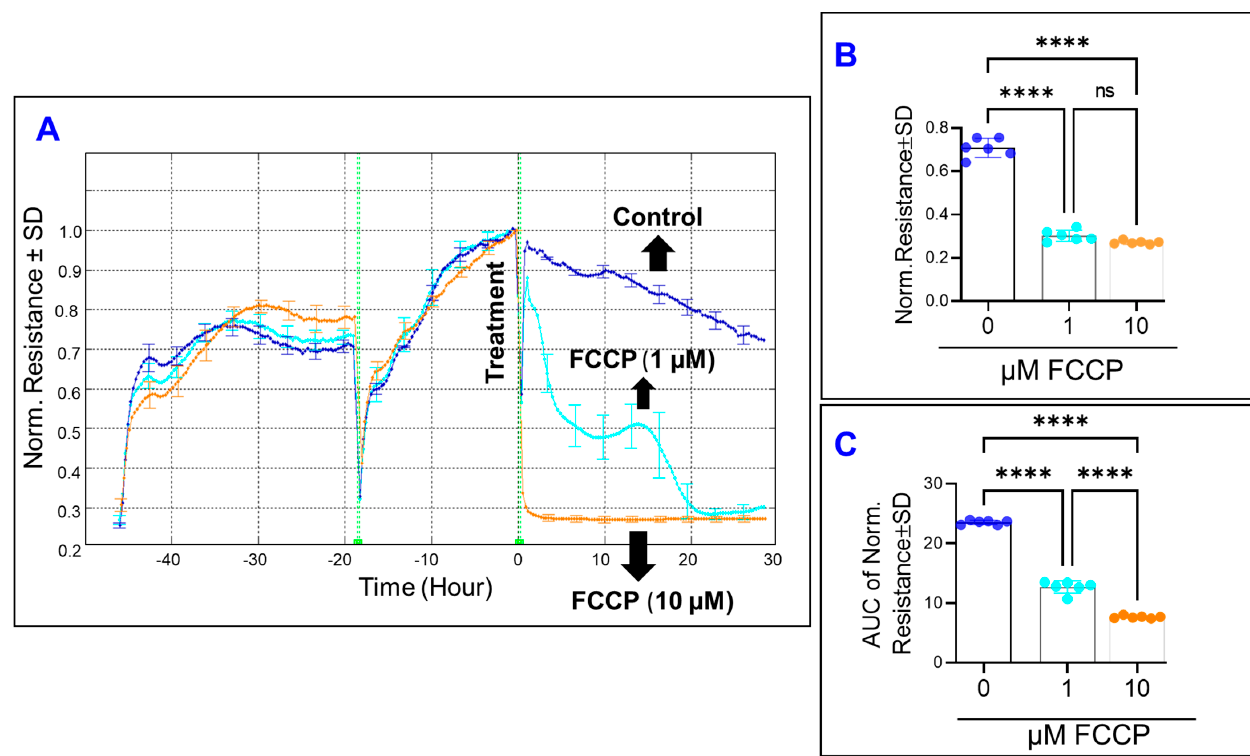
Figure 3. Real-time measurement of human retinal endothelial cells’ total resistance treated with OxPhos uncoupler (FFCP). ( A ) The total resistance across HRECs after treatment with vehicle (DMSO) or FCCP (1 and 10 µM) was represented by plotting normalized resistance vs. time, measured at an AC frequency of 4000 Hz. When treatment started, the resistance value at time 0 (R 0 ) was used to normalize all other resistance measurements. ( B ) The bar graph represents each group’s normalized resistance at the endpoint (t = 30 h). ( C ) The bar graph represents each group’s area under the normalized resistance curve between the time interval t = 0–30 h. Statistical analysis was performed using the ANOVA test followed by the Tukey post hoc test. Abbreviations: Norm, normalized; AUC, area under the curve; ****, p ≤ 0.0001; ns, no significance. After having shown that uncoupling OxPhos alters the barrier functionality of three parameters that govern the total resistance of cells, which include: R b (the intercellular resistance); α (the basolateral adhesion of HRECs to the substrate) and C m